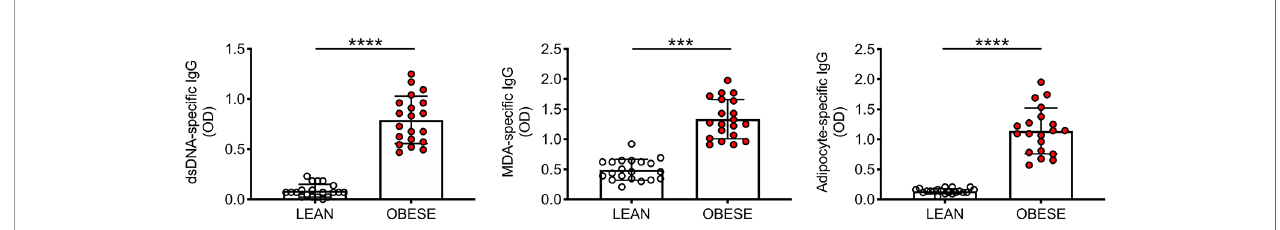
FIGURE 1 | The plasma of individuals with obesity is enriched in IgG antibodies speci fi c for dsDNA, MDA and adipocyte-derived antigens. Plasma samples were isolated from individuals with obesity and from lean controls. Mean comparisons between groups were performed by Student ’ s t test (two-tailed). ***p < 0.001, ****p <